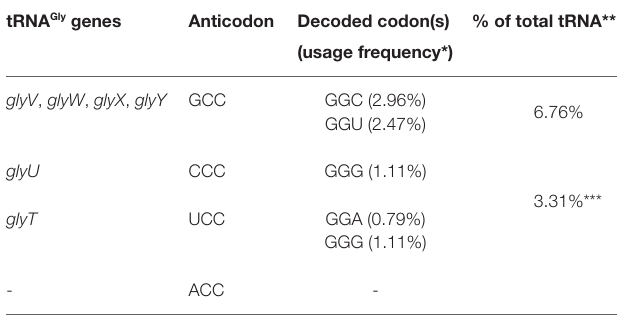
TABLE 1 | tRNA Gly coded in E. coli K-12 MG1655 genome.